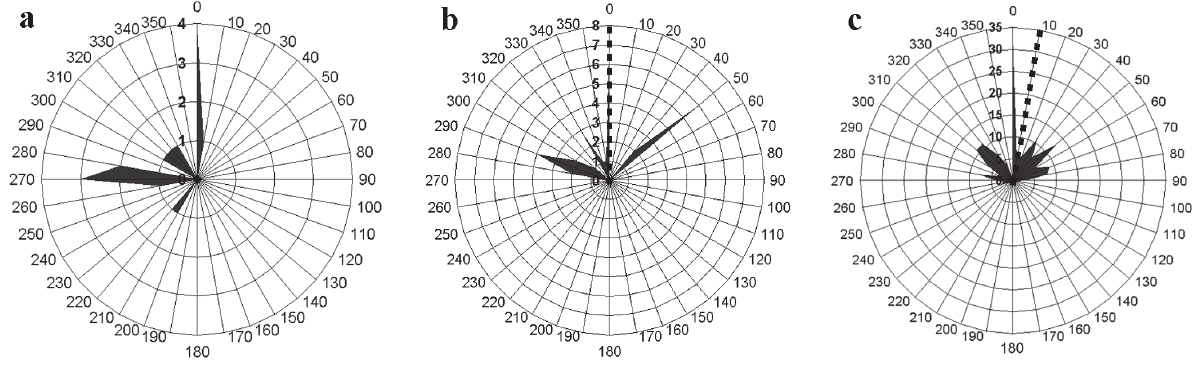
Fig . 4. − rose diagrams reporting shell orientation in the M